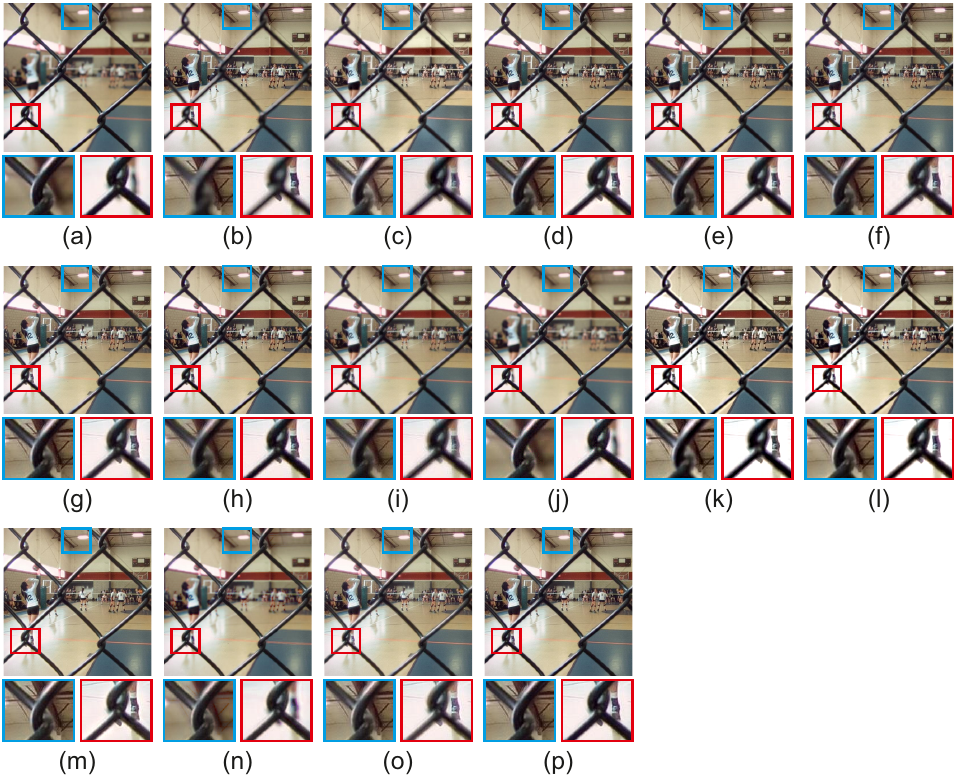
Figure 14. Fused results for the scene ‘Volley’ of the Lytro dataset [35]. ( a ) Source 1, ( b ) Source 2,